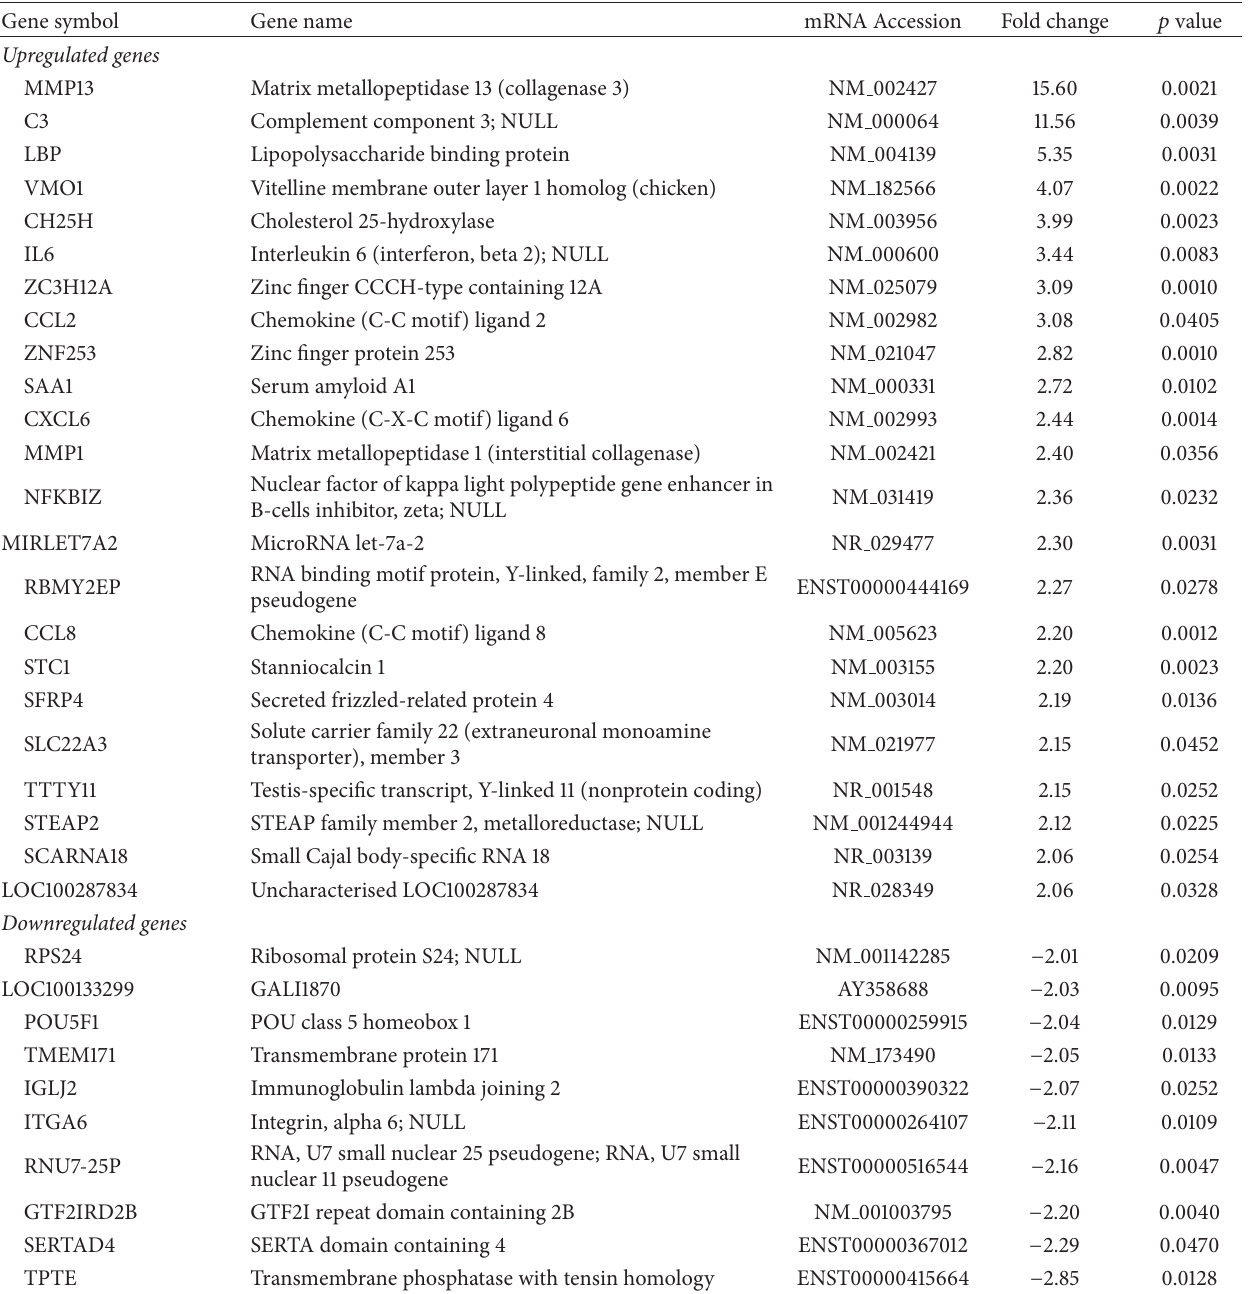
Table 2: Differentially expressed genes (mapped by DAVID): MSC-17 versus